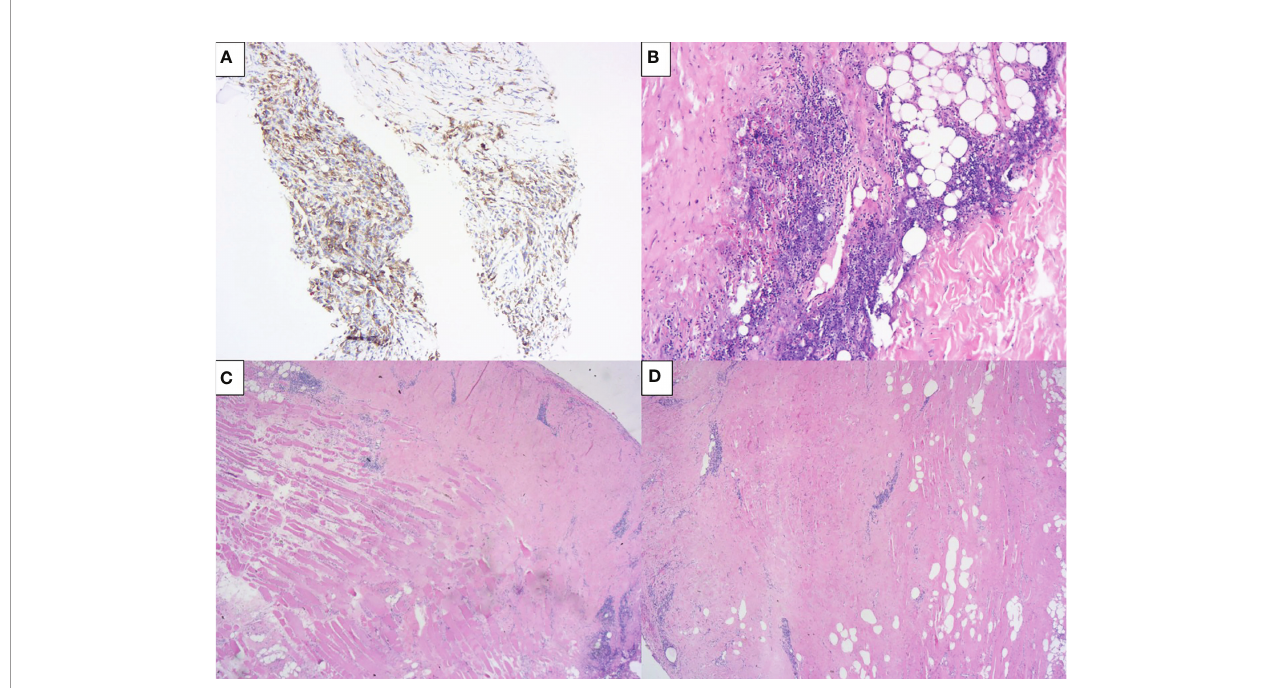
FIGURE 4 | PD-L1 immunohistochemistry and pleural decortication slides. (A) Membrane PD-L1 expression on 80% of tumor cells (22C3 antibody) without signi fi cant lymphocytic in fi ltrate in the pre-treatment biopsy; (B – D) Pleural decortication slides showing a complete pathological response, characterized by fi brosis, multifocal chronic lymphocytic in fi ltrate and focal necrosis; no viable neoplastic cells were seen after exhaustive